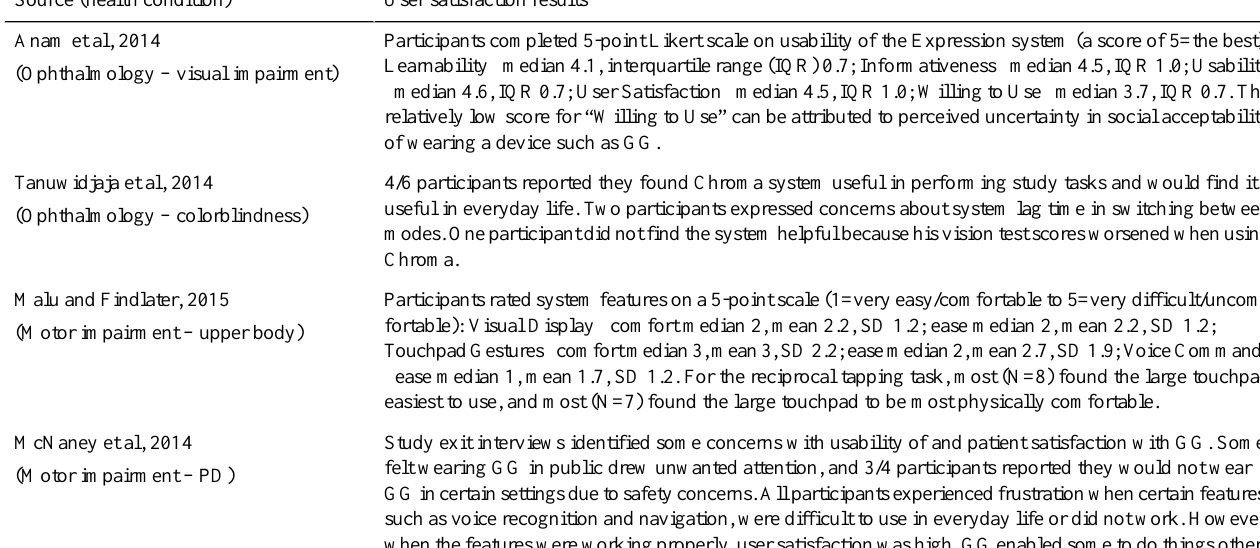
User satisfaction resultsSource (health